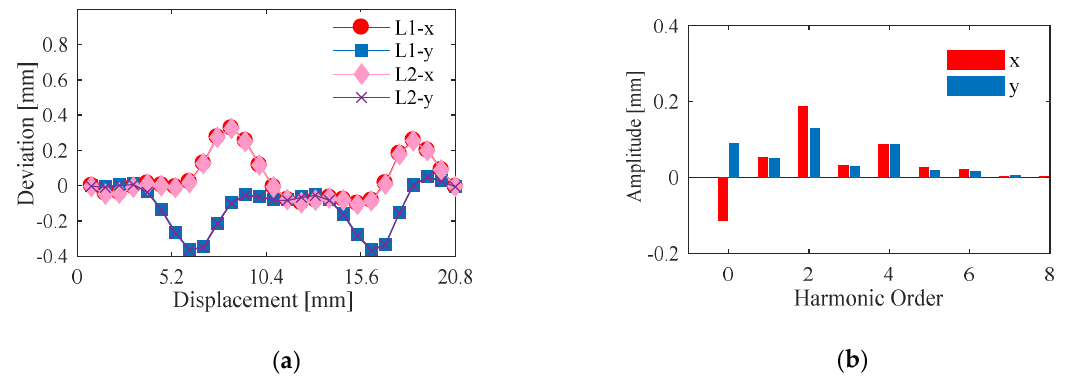
Figure 12. Measurement results of the sensor prototype. ( a ) Comparison of deviations in two pitches along x- and y-axis. ( b ) Harmonic distribution of deviations in one pitch.